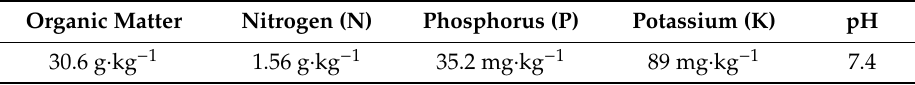
Table 1. Chemical properties of experimental